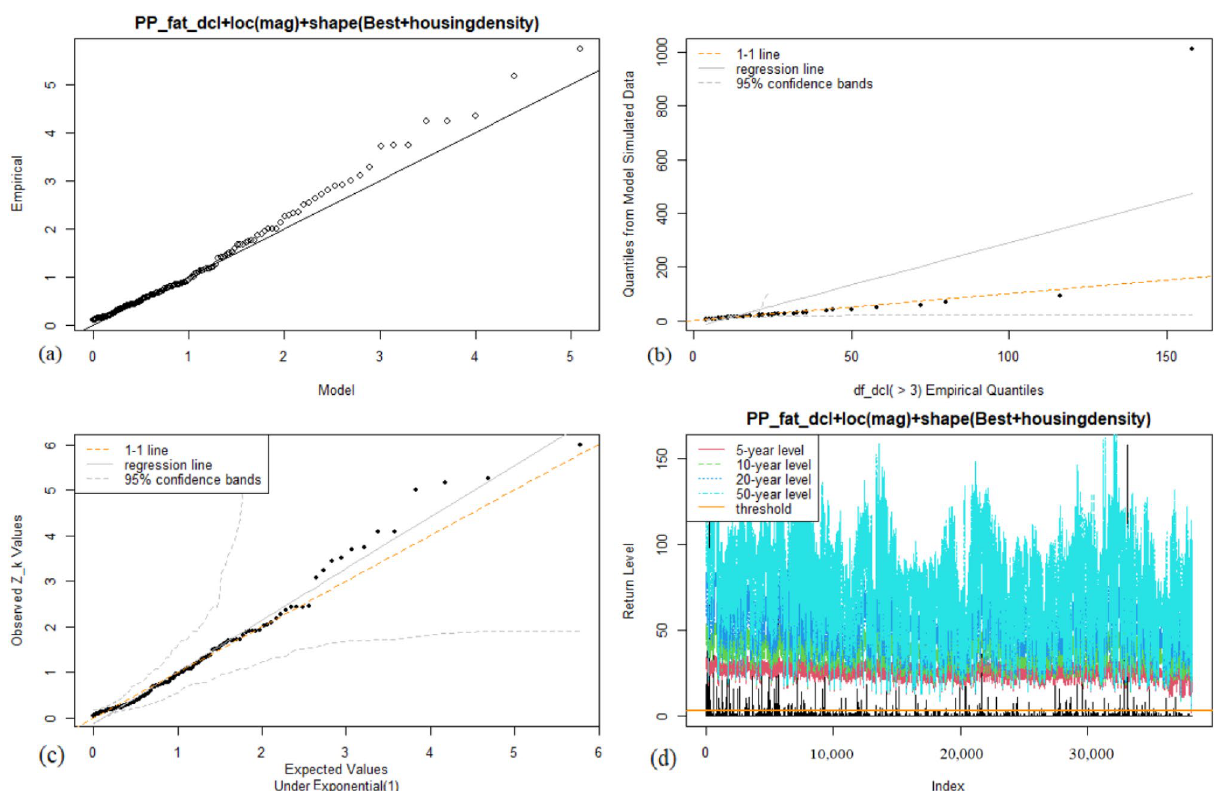
density plot of the data, along with the model fitted density; and d a return level plot